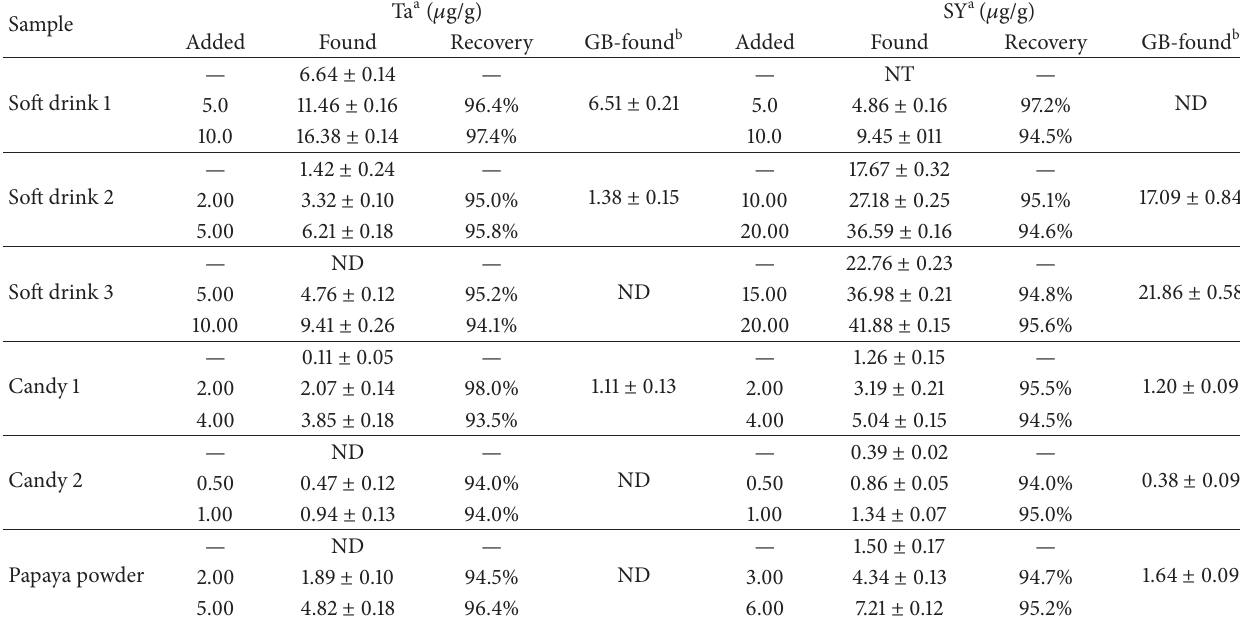
Table 2: Determination of SY and Ta in food sample and recovery test ( 𝑛 = 3